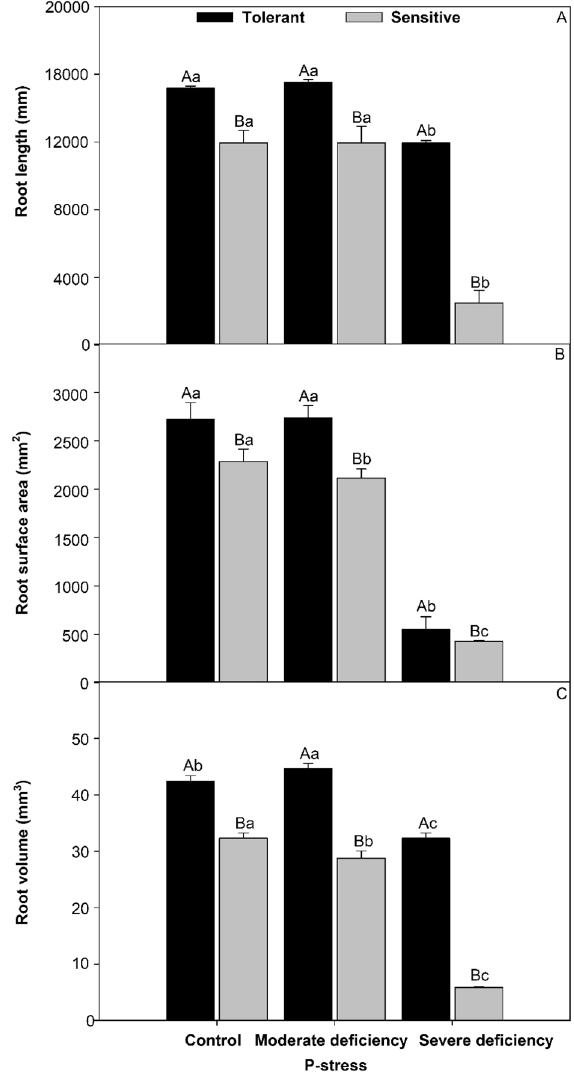
Figure 2. Root length ( A ), root superficial area ( B ), and root volume ( C ) in cultivars tomato treated P-stress. Columns with different capital letters compare cultivars (tolerant and sensitive) between P stress levels (control, moderate deficiency, and severe deficiency). Lowercase letters compare cultivars (tolerant and sensitive) with the same color as a function of P stress levels (control, moderate deficiency, and severe deficiency). Different letters differ by the Scott–Knott test (P < 0.05). Columns corresponding to means of six repetitions and standard